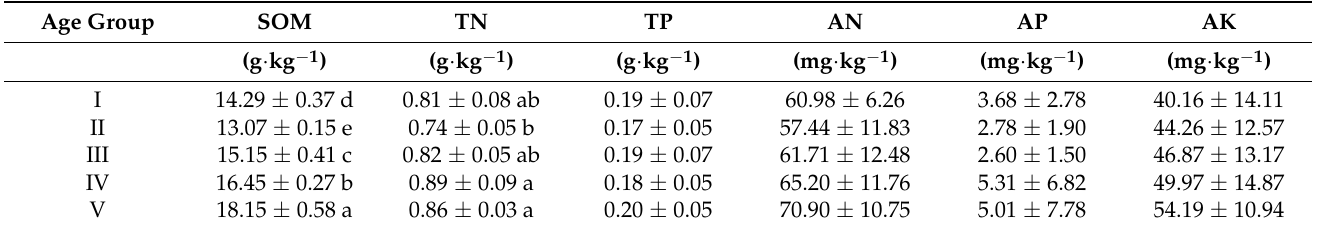
Table 1. The nutrient contents of soils (from 0 to 60 cm) in each age group of Chinese fir forest stands. Note: lower case letters indicate significant differences ( p < 0.05).